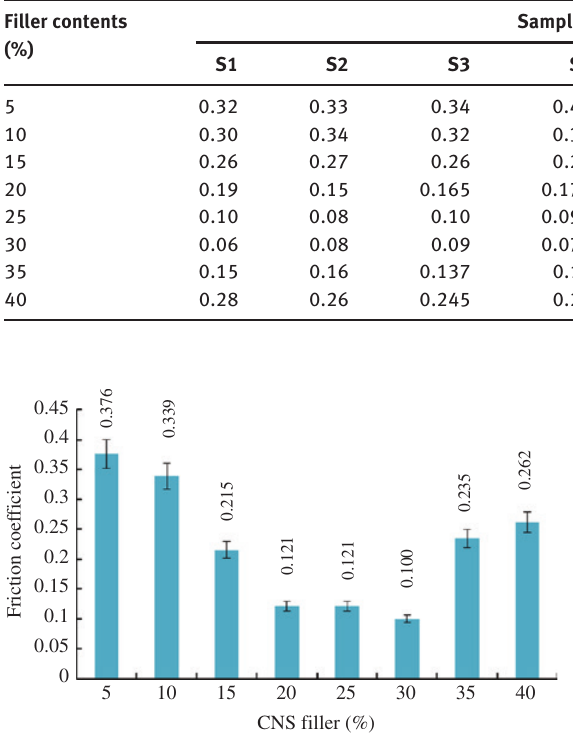
Figure 9: Friction coefficients of the raw CNS filler epoxy compos- ites with various filler